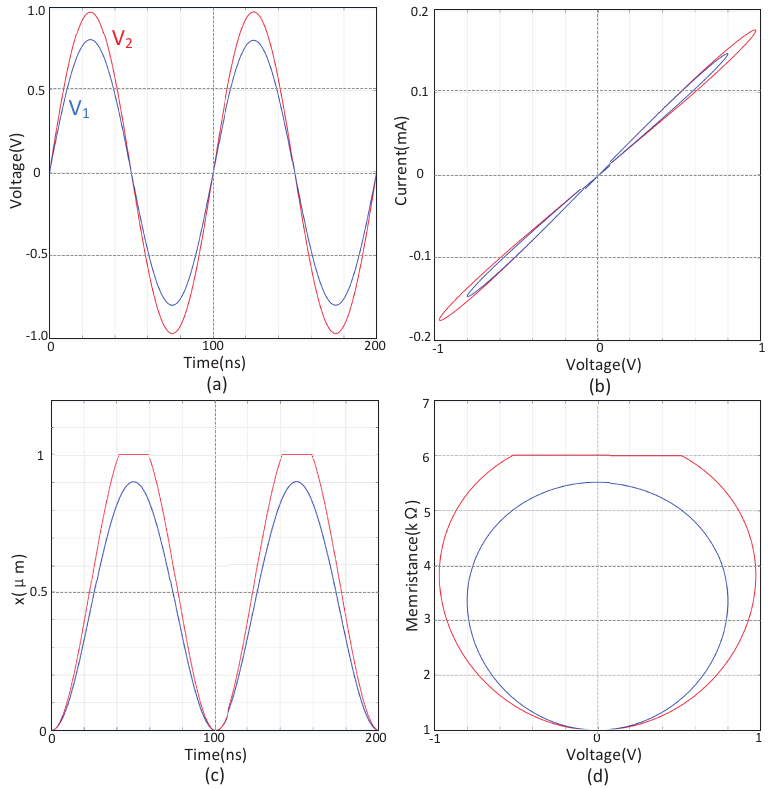
Figure 2. Simulation results of spin memristor ( V 1 < V 2 ). ( a ) Time-Voltage curve, ( b ) Voltage-Current curve, ( c ) Time-Magnetic domain wall moving distance curve, ( d ) Voltage-Memristance